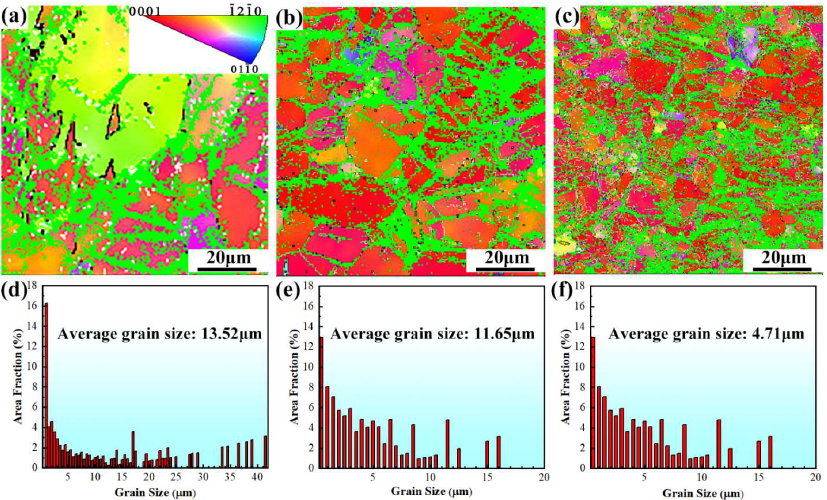
Figure 3. IPF maps of ( a ) R30 alloy; ( b ) R50 alloy; and ( c ) R70 alloy. Statics of grains in ( d ) R30 alloy; ( e ) R50 alloy; and ( f ) R70 alloy.